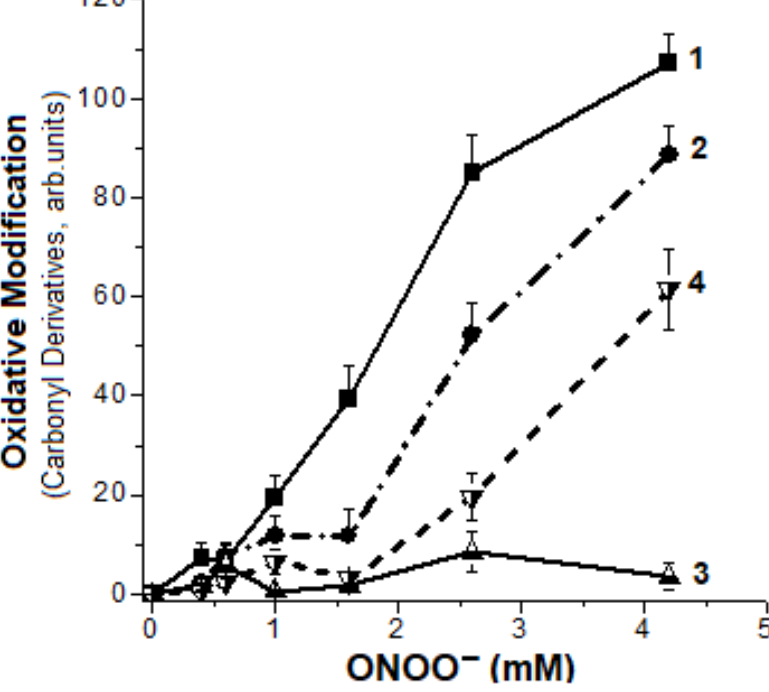
Figure 3. Formation of metHb carbonyl derivatives under the impact of various concentrations of peroxynitrite. Reaction mixture contained—0.2 M Na,K-phosphate buffer (pH 6.8) and 0.15 mM Hb-DNICs (Hb concentration). Curves 1 and 3metHb, curves 2 and 4—Hb-DNICs, curves 3 and 4—with DTPA. The modification was carried out at the following concentrations of ONOO – in the reaction medium: 0 мМ , 0.38 мМ (1:2.5), 0.6 мМ (1:4), 1 мМ (1:6.5), 1.6 мМ (1:10.6), 2.55 мМ (1:17),